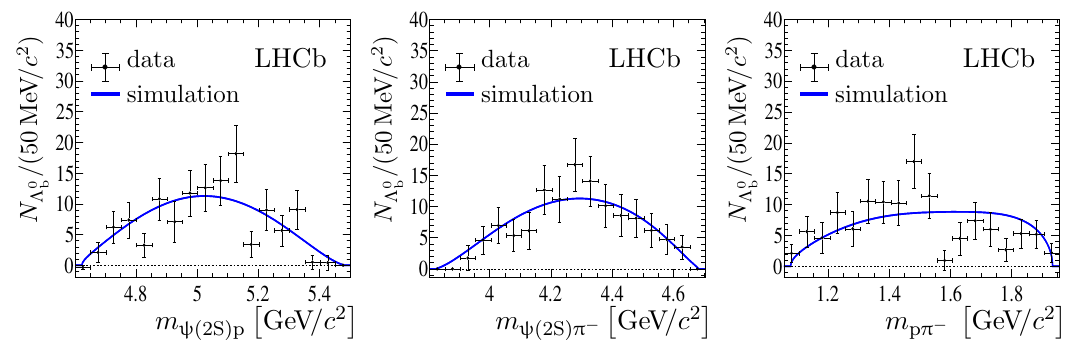
Figure 2 . Background-subtracted mass distributions of the (left) (2S)p, (centre) (2S) (cid:25) (cid:0) and (right) p (cid:25) + combinations in the (cid:3) 0 ! (2S)p (cid:25) (cid:0) decay compared with distributions obtained from b a phase-space